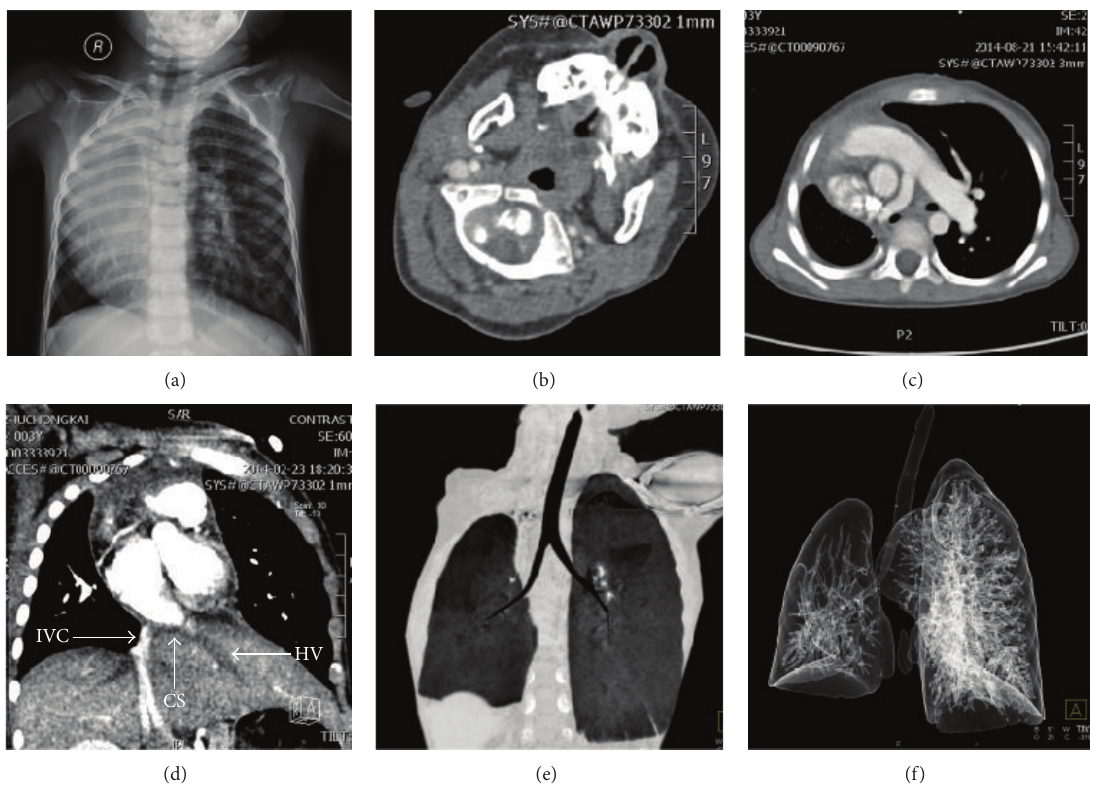
Figure 2: X-ray chest showing (a) a homogenous opacity occupying most of right hemithorax and compensatory hyperinflation on left side. Cranial computed tomography demonstrating (b) imperforation of right external acoustic meatus. The CECT chest in mediastinal window showing (c) right lung hypoplasia, left lung tissue crossing through the mediastinum, and hypoplastic right pulmonary artery and (d) hepatic vein that directly drains into right atrium thorough coronary sinus. CECT chest in lung window showing that (e) the right side of thoracic cage is mildly collapsed and no obvious branches of the right main bronchus could be observed. Volume-rendering computed tomography 3-dimensional reconstruction showing (f) right lung hypoplasia and a compensatory hyperplasia left